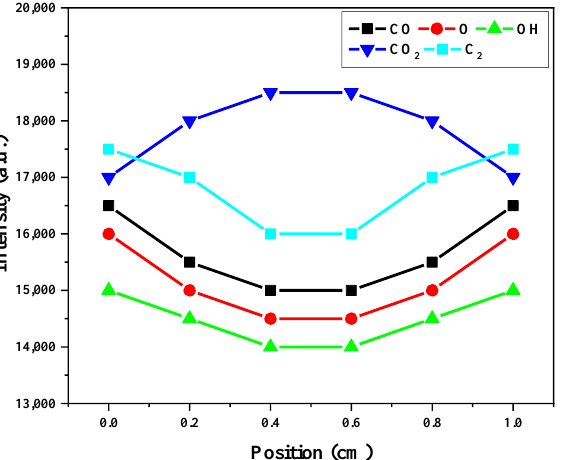
Figure 5. Emission spectrum of the AC-PPP at the AC voltage of 22 kV and the position z=5 mm. Table 5. Detected peaks for the AC-PPP reactor with CO 2 gas.